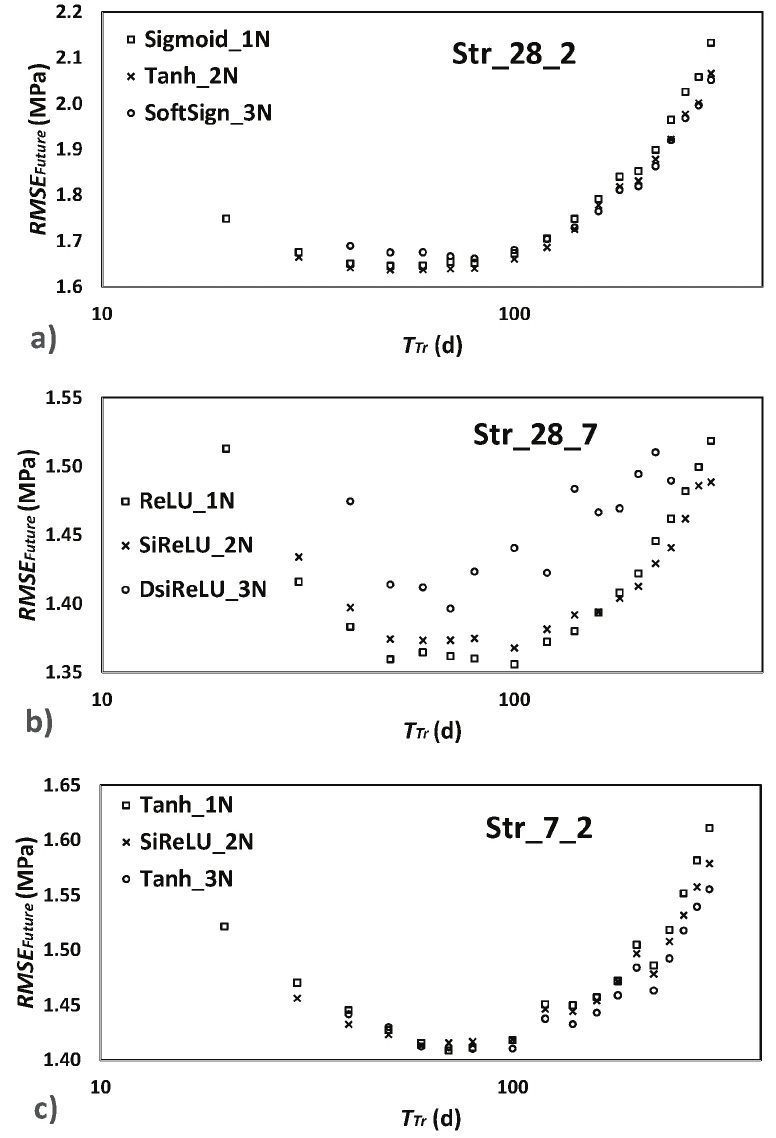
Fig. 6 – Effect of the training period on RMSE